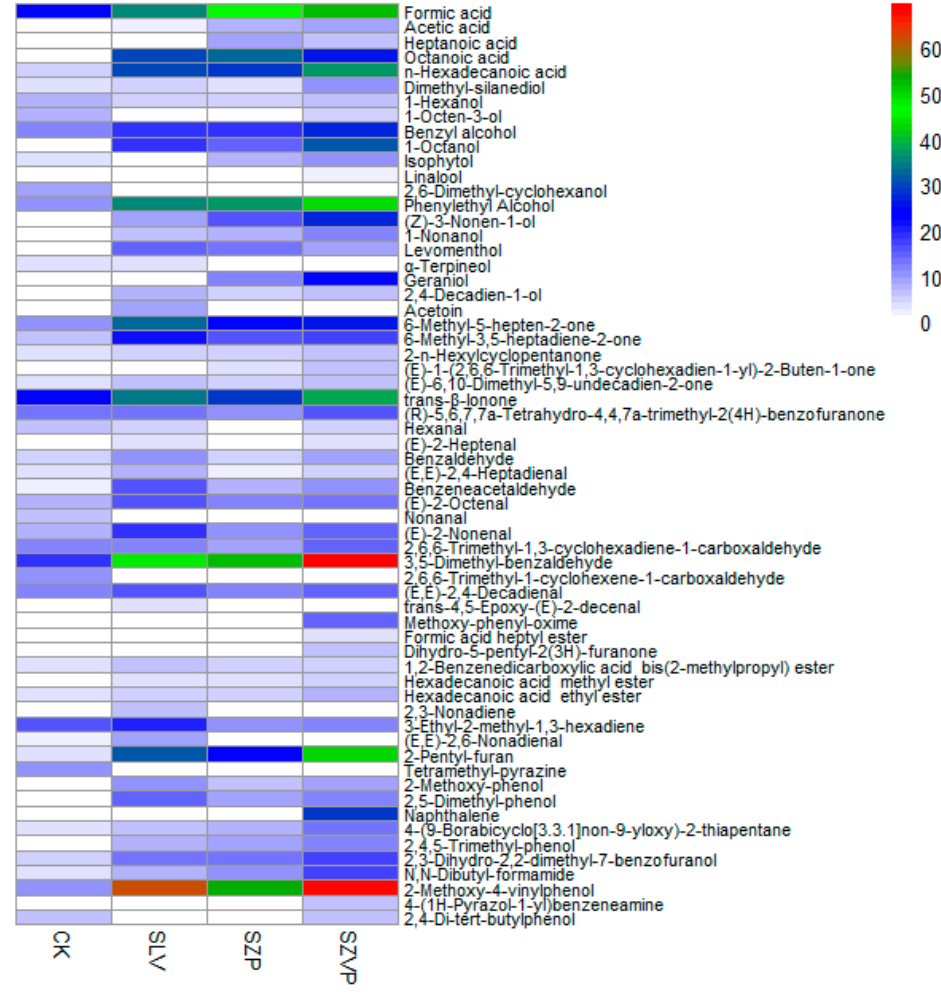
Figure 1. The contents of volatile compounds in the fermented goji juice by different bacteria (µg/100 g). The heat map was based on the contents of volatile compounds detected in fermented and unfermented goji juice. The scale ranging from 0 (white) to 70 (red) was used to show the contents of volatile matters (µg) in 100 g goji juice.